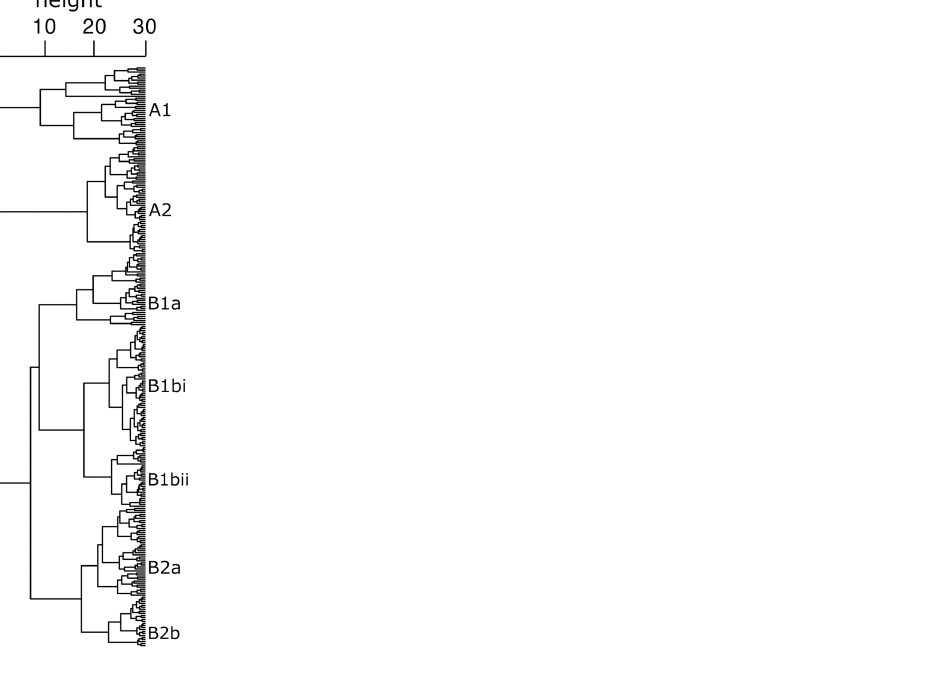
Figure 3. The dendrogram produced by the hierarchical cluster analysis with the most resolved seven-group classes shown. The number of reaches in each class were A1 (39), A2 (53), B1a (36), B1bi (60), B1bii (30), B2a (44), and B2b